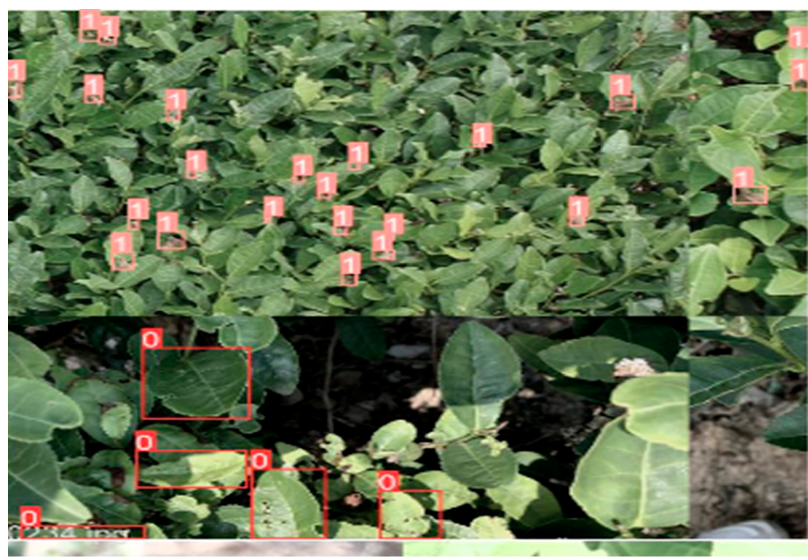
Figure 4. Schematic of mosaic online data enhancement.